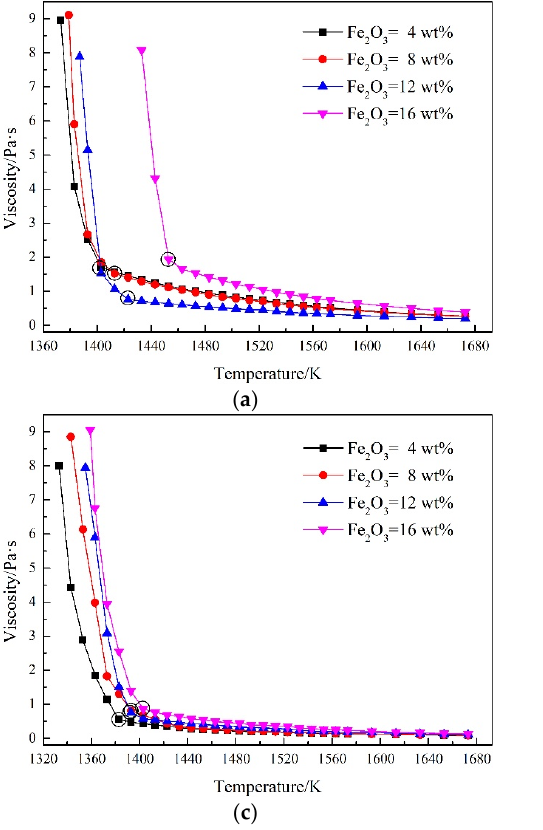
Figure 9. Viscosity changes versus temperature of the FeO − Fe 2 O 3 − SiO 2 − 8 wt%CaO − 3 wt%MgO − 3 wt%Al 2 O 3 system at different Fe 2 O 3 content and fixed Fe/SiO 2 ratios of ( a ) 0.8; ( b ) 1.0; ( c ) 1.2; ( d ) comparison with other studies (Fe/SiO 2 = 1.32 data from [12], Fe/SiO 2 = 1.27 data from [24], Fe/SiO 2 = 1.2 data from [40], Fe/SiO 2 = 1.51 data from [41]).